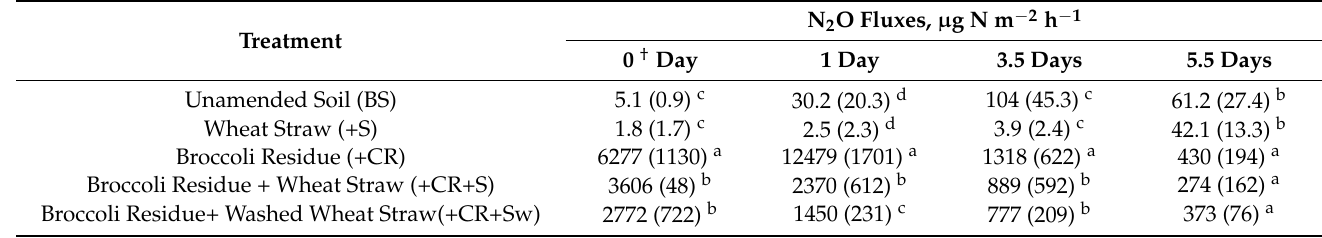
Table 1. Nitrous oxide fluxes from soil microcosms on different days following the broccoli residue and wheat straw amendments.